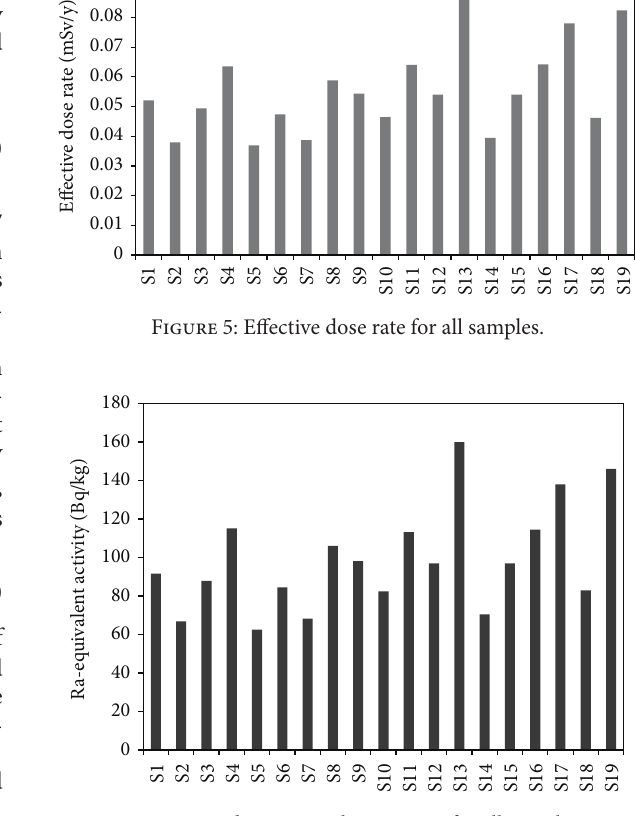
Figure 6: Radium equivalent activity for all samples.